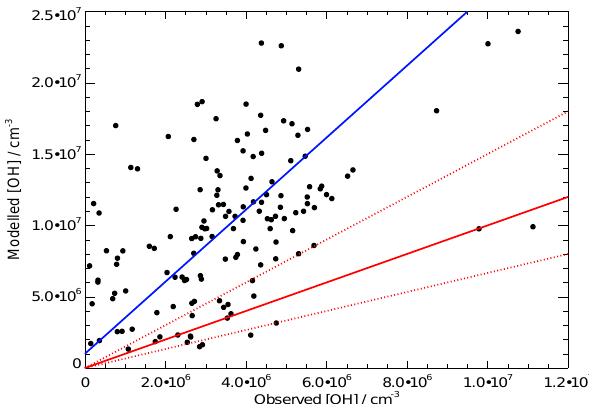
Fig. 3. Comparison between modelled and observed OH concentrations. The 1:1 line is shown by the solid red line, with dashed red lines indicating 50% limits on the 1:1 line. The best fit to the data is given in blue and is described by y = ( 2 . 53 ± 0 . 43 )x +[ ( 1 . 00 ± 1 . 60 ) × 10 6 ], with r 2 = 0 . 75.